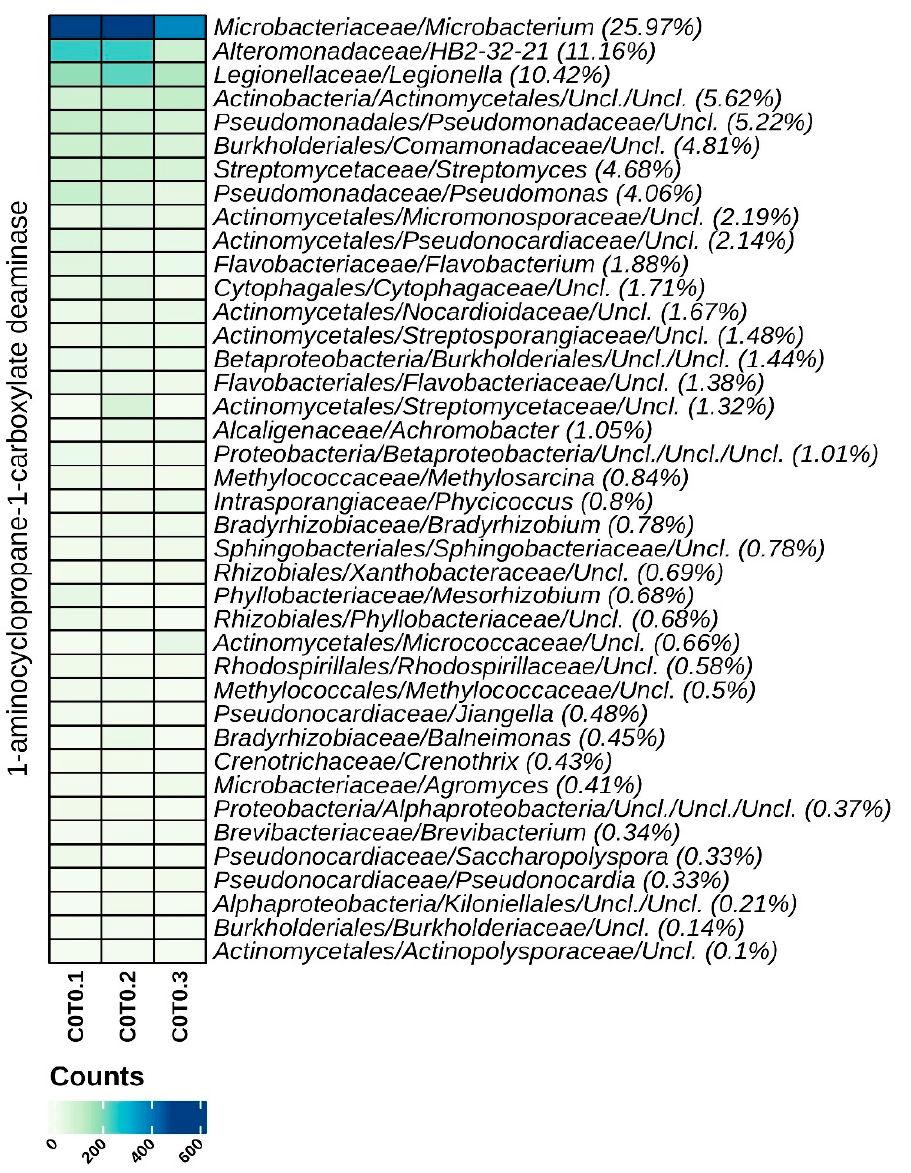
Figure 9. Functional Heatmaps of the Aminocyclopropane-1-carboxylate deaminase activity identified ASVs aggregated at the Genus level, as inferred by PICRUSt2 in the three biological replicates. On rows, the nearest identified taxonomic level for each contributing ASV is reported, followed by its relative percentage contribution to the functional feature. Hierarchical clustering of columns was performed by Pearson correlation, based on Euclidean distance.